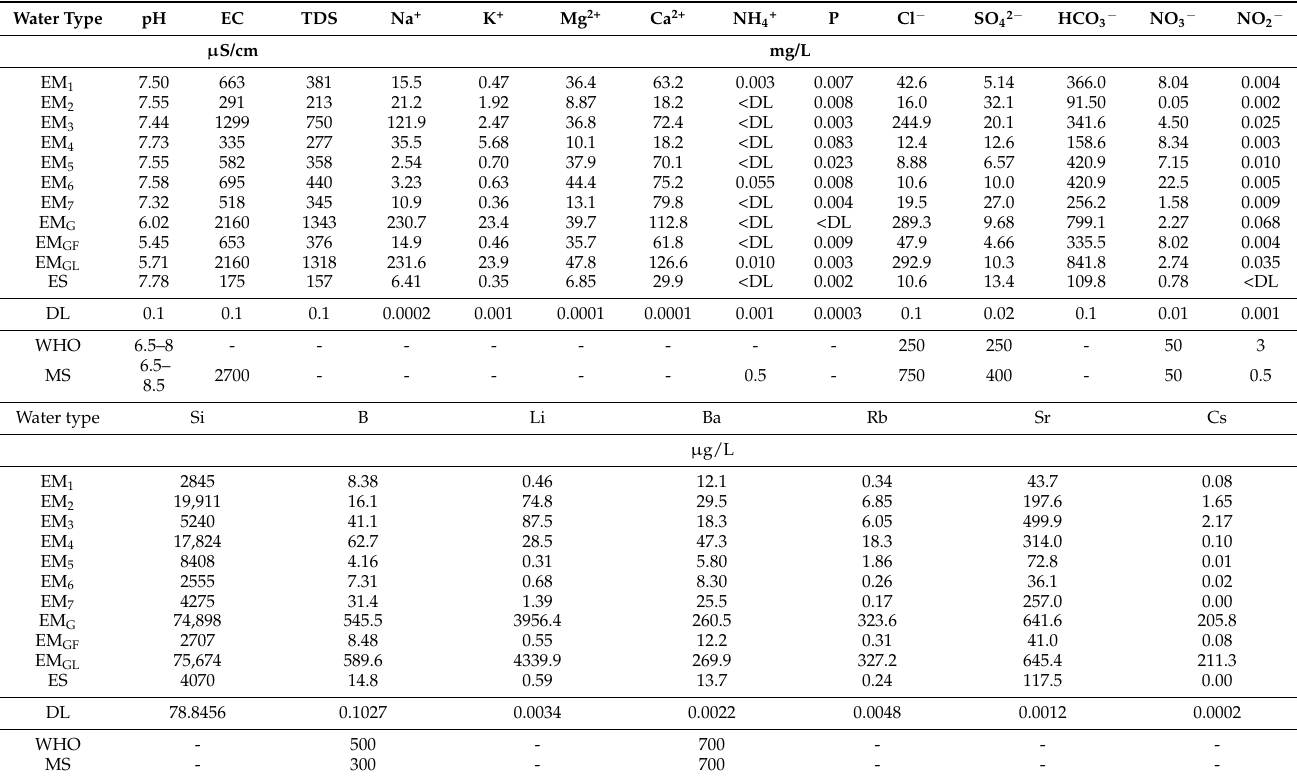
Table 2. Average analytical results for bottled water in